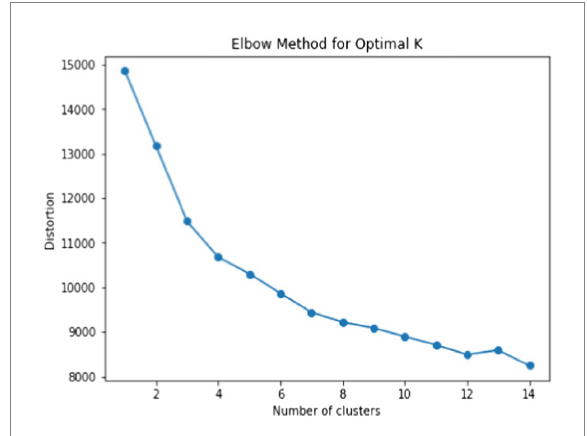
FIGURE 5 Result of elbow method for determining optimal k for students with the correct answer.